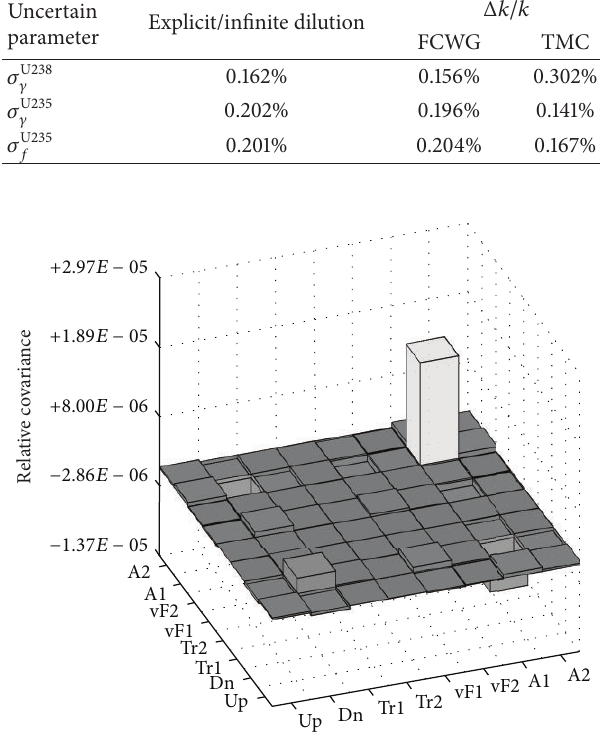
Figure 23: Homogenized property covariance due to infinite- dilution 𝜎 U 238 𝛾 covariance.